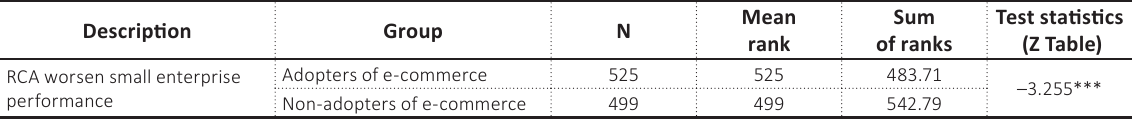
Table 5. Mann-Whitney test results for restrictions to community activities worsen small enterprise performance